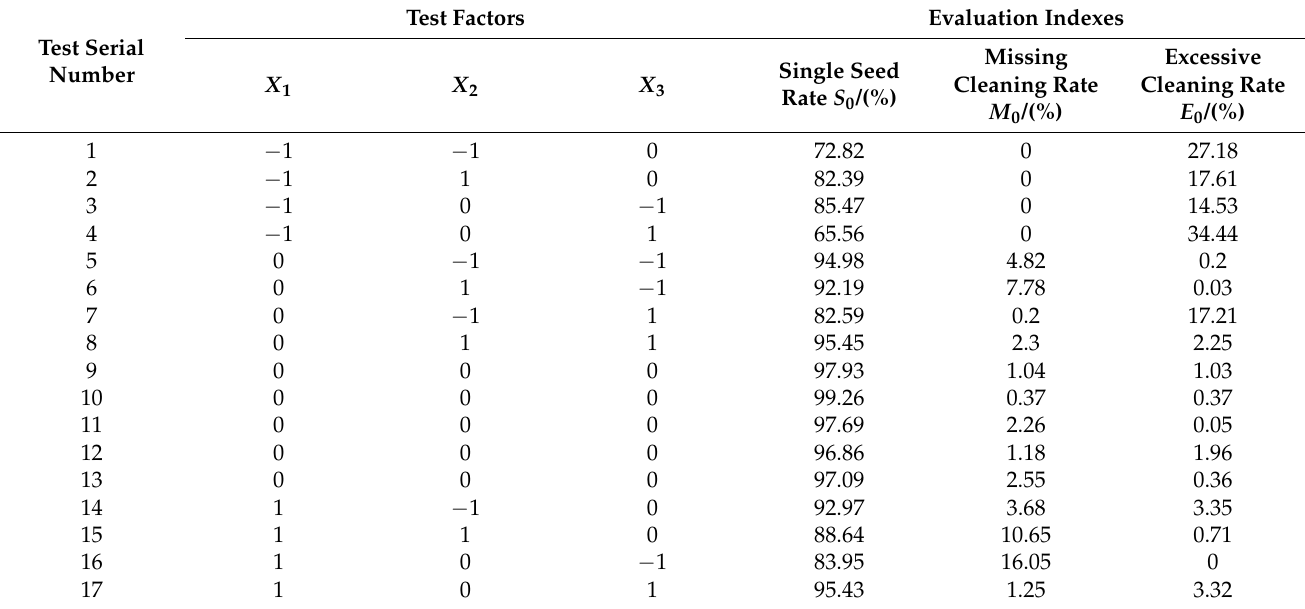
Table 3. Box–Behnken test protocol and